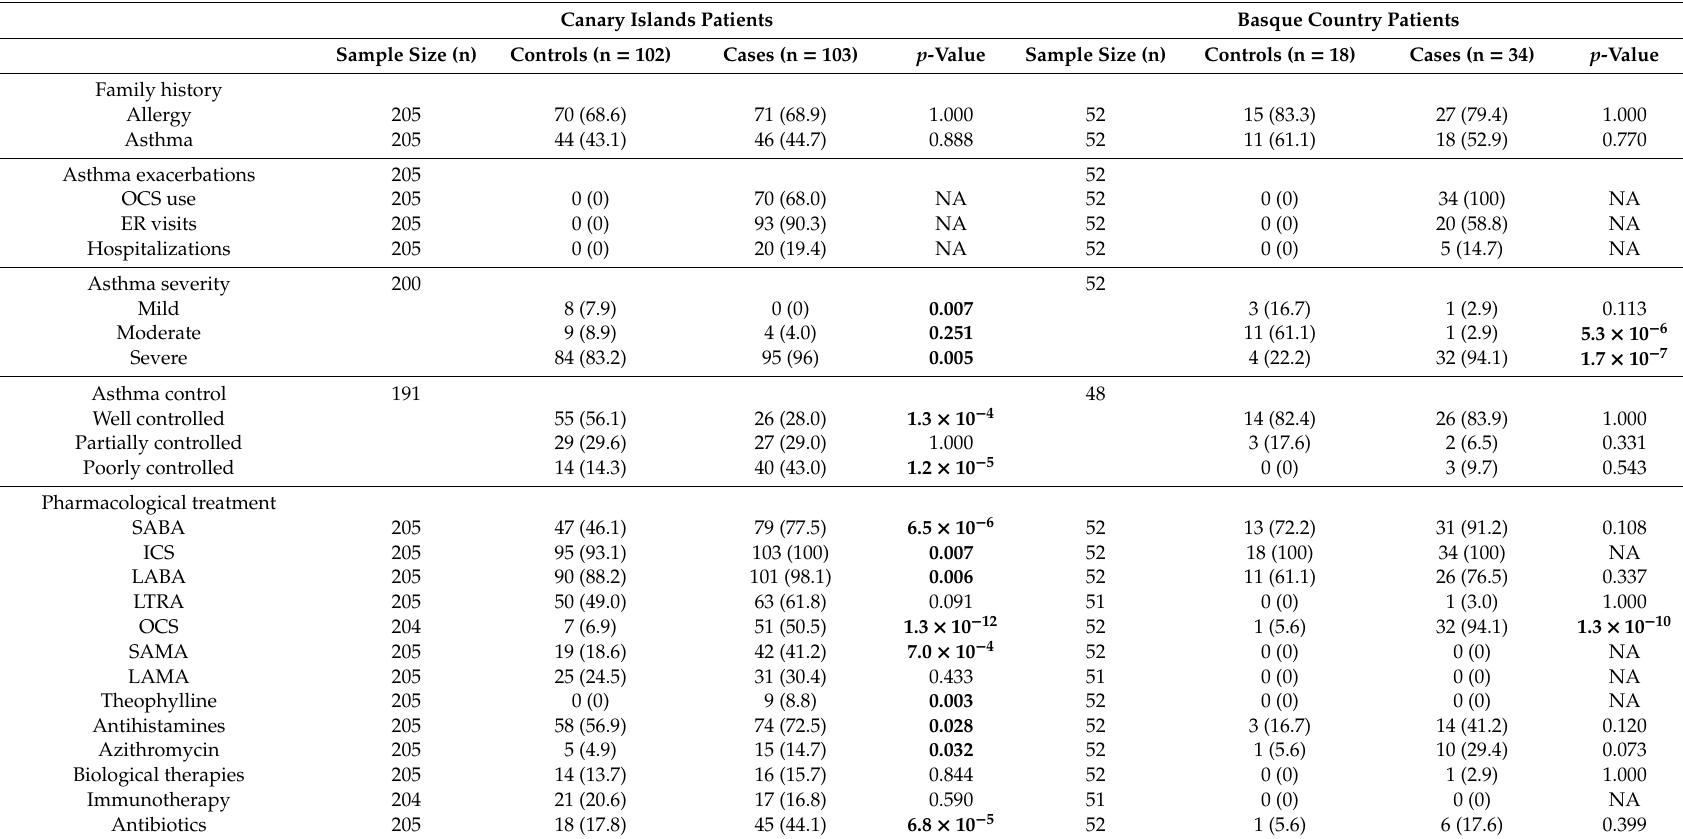
Table 2. Description of patients with asthma recruited in the GEMAS